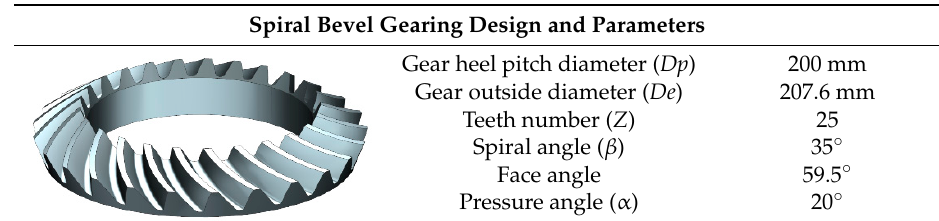
Table 1. Spiral bevel gear geometry and parameters.